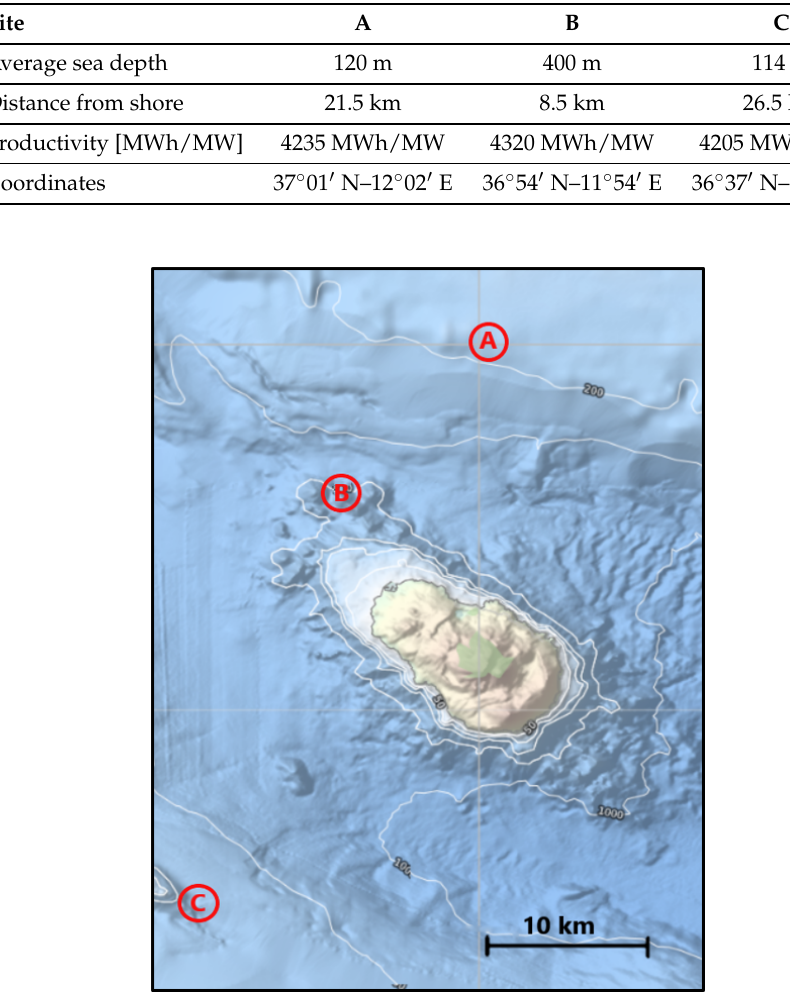
Figure 15. Pantelleria’s